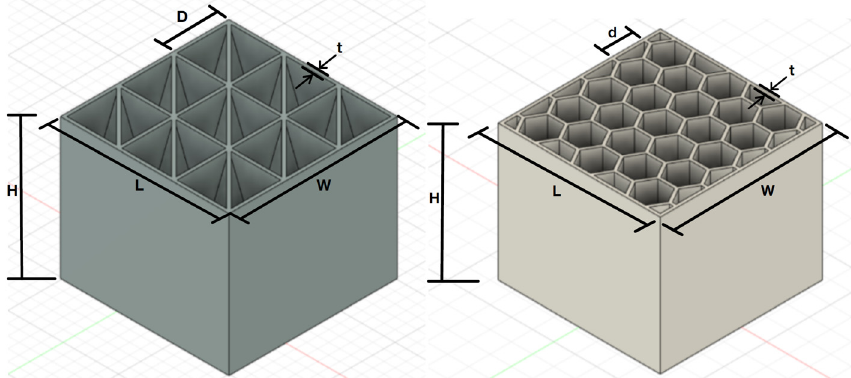
Figure 2. Two samples, one made with cells with the novel cell geometry with variable section, and the other with a standard hexagonal geometry, having the same external dimensions (and mass). The dimensions, here indicated by letters, varied between the two different scales considered, but the number of cells was kept constant for each of the two honeycomb geometries.